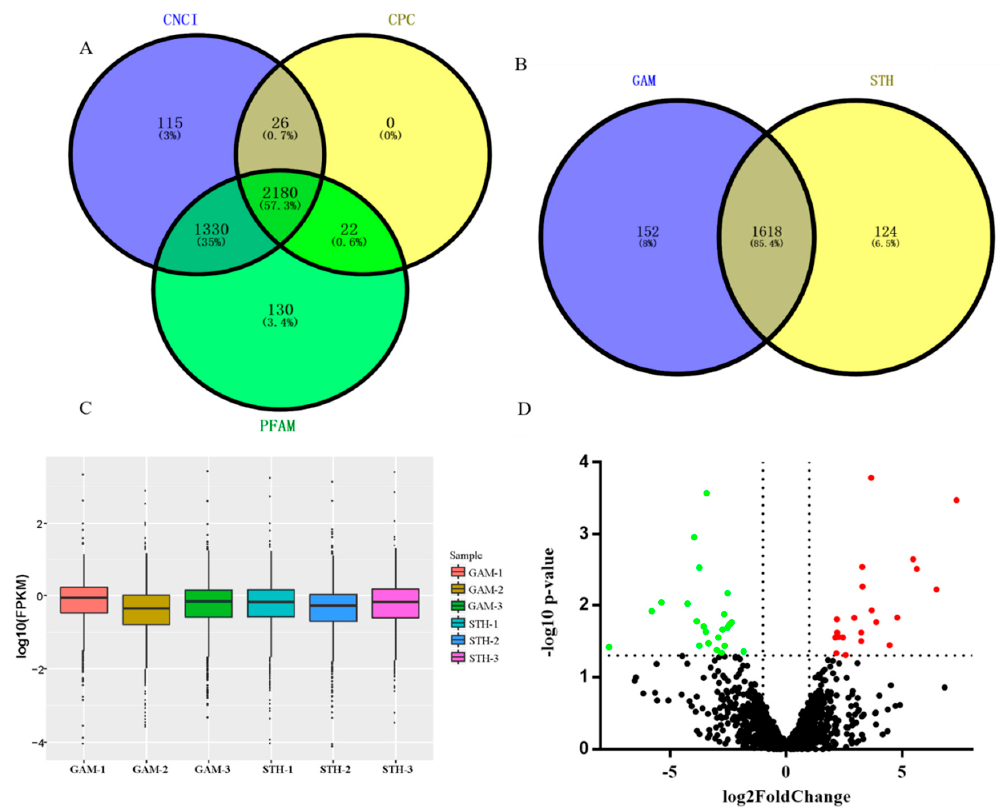
Figure 1. The characteristics analysis of lncRNAs obtained from RNA-Seq. ( A ) Venn diagram analyzing the coding potential analysis using Coding Potential Calculator (CPC), Coding-Non-Coding Index (CNCI), and Protein Families Database (PFAM). ( B ) Venn diagram summarizing the number of lncRNAs expressed only in the Small-Tailed Han (STH) ewes, expressed only in the Gansu Alpine Merino (GAM) ewes, and common to both groups. ( C ) The FPKM density distribution of lncRNA expression in sheep mammary gland between GAM and STH ewes. ( D ) Volcano plot comparing the change in lncRNAs’ expression of the STH and GAM ewes. The red and green dots indicate up-regulated and down-regulated lncRNAs in mammary gland of STH compared with the mammary gland of GAM, respectively ( p < 0.05). The black dots represent lncRNAs that are not significantly different in the two breeds of sheep ( p > 0.05).